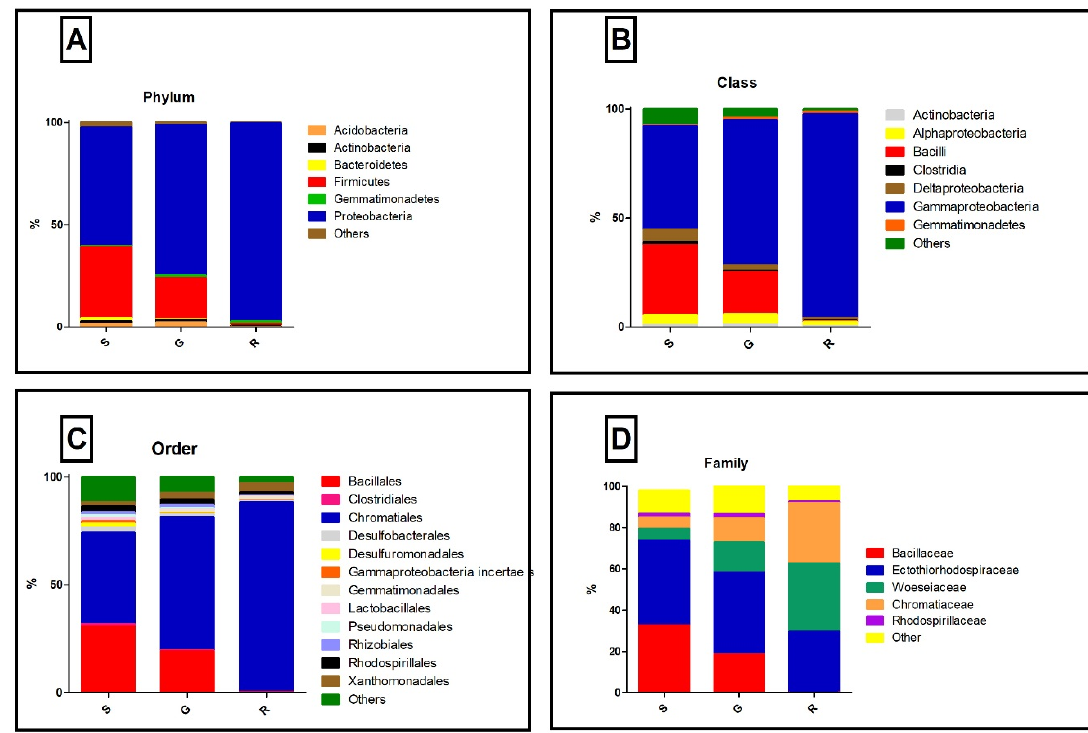
Figure 1. Taxonomic classification of 16S rDNA reads for the cave samples. Sediment (S), Gravel-like (G), and Rock (R) samples. ( A ) Phylum level, ( B ) Class level, ( C ) Order level, and ( D ) Family level with EzBiocloud database.